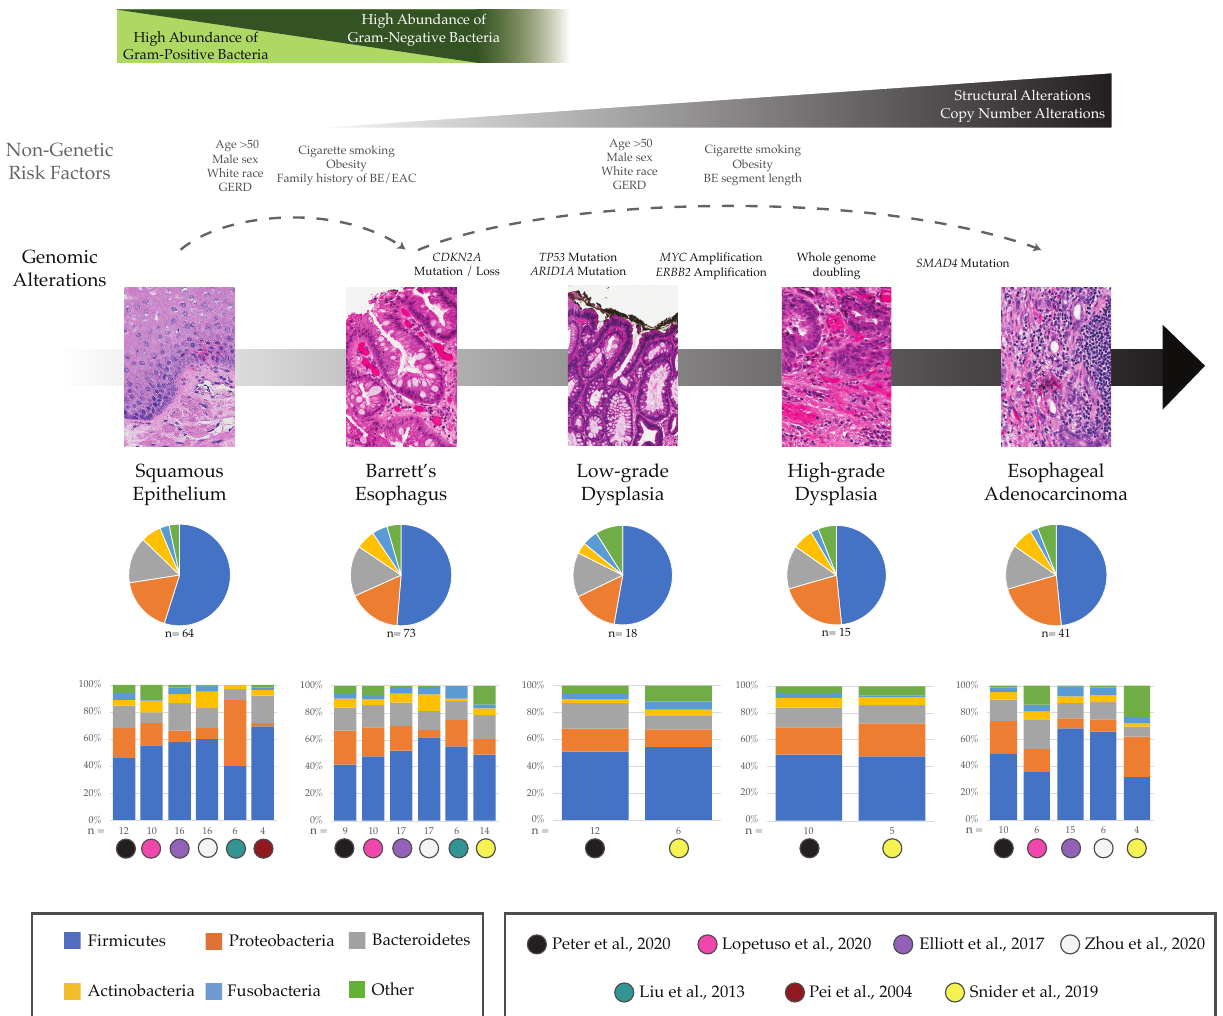
Figure 1. Microbial and genomic changes in the progression from BE to EAC. The stages of progression from normal tissue to EAC with corresponding non-genetic risk factors for BE and BE-EAC progression [7,40–43], common genomic changes frequently detected [44–51] as well as general trends expected in increasing Gram-negative bacterial species in BE [38,52]. Relative abundances reported across the phylum level at each stage are provided in aggregate (pie charts) and in each study individually (bar plots) to highlight study-specific heterogeneity [34–39,53]. Note, technical differences including analysis pipelines can lead to differences among studies beyond the biological differences likely to be present in the samples. Additional methods would need to be applied to distinguish methodological differences from cohort or stage differences across studies. Recent analysis methods such as differential ranking can help resolve stage differences and identify clinically significant microbial changes [54]. Hematoxylin and eosin stain images courtesy of Matthew Stachler, UCSF. GERD, gastroesophageal reflux disease; BE, Barrett’s esophagus; EAC, esophageal